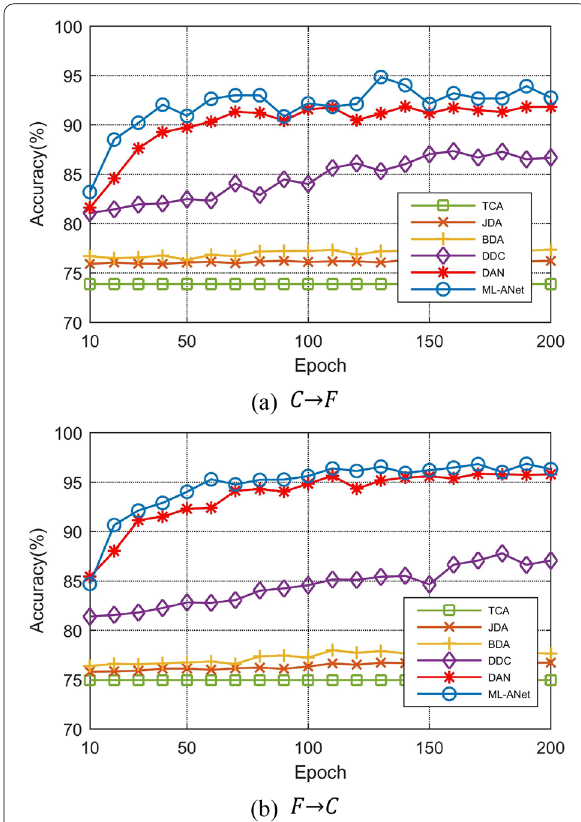
Figure 5 a and b are the classification accuracy comparison of